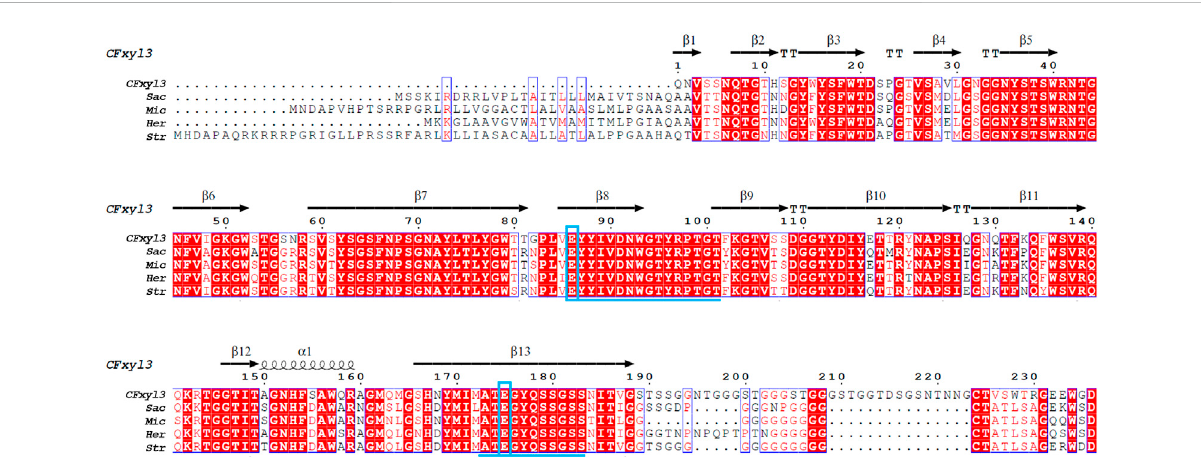
FIGURE 1 PrimarystructuresmultiplealignmentbetweenCFXyl3andfourtypicalxylanasesfromfamily11.Abbreviations:CFXyl3(WP_013115499.1,inthis work); Str, Streptomyces (WP_093661817.1); Sac, Saccharothrix (NUT48201.1); Mic, Micromonospora (WP_168002960.1); and Her, Herbidospora cretacea (WP_051760875.1).Theduplicateresiduesamongthesexylanasesshowedinredbackground.Thetwoblueboxedlettersmarkthecatalytic residues Glu86 (acid/base) and Glu175 (nucleophile), numbered by CFXyl3. The underlined amino acid sequence indicated two conserved motifs. The catalytic residues are indicated with blue boxes. One α -helix and 13 β -strands in CFXyl3 are represented as a black coil and black arrows,